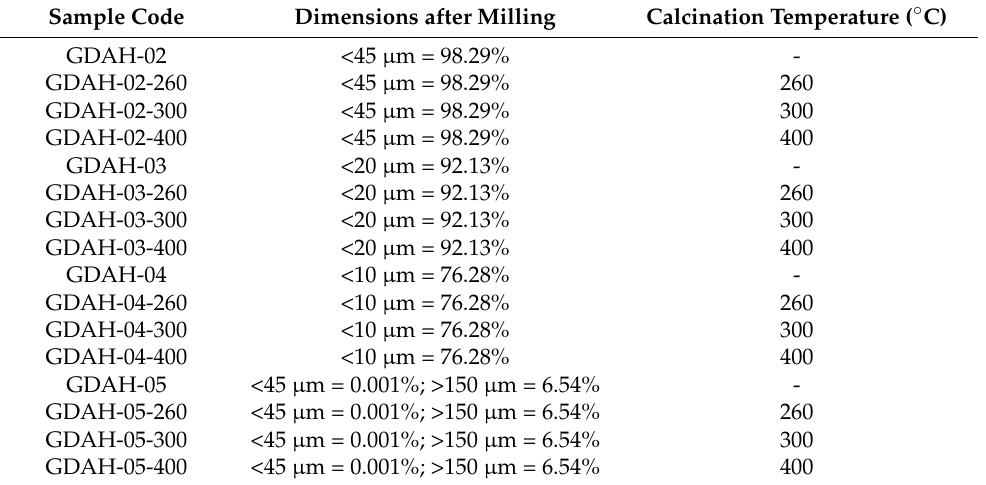
Table 1. Samples of dried, milled, and thermally treated aluminum hydroxide classified by particle size